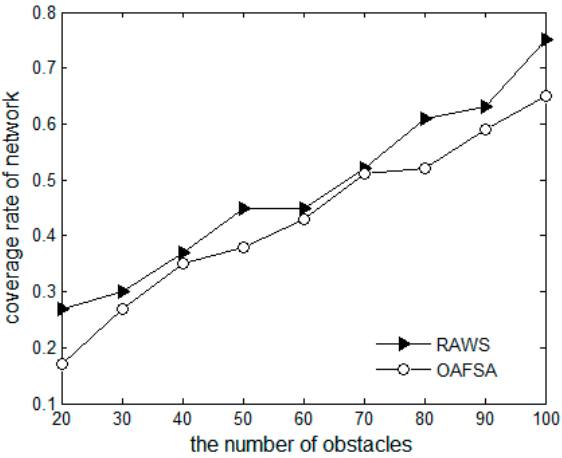
Figure 9. Comparison of network coverage rate at varying numbers of nodes.